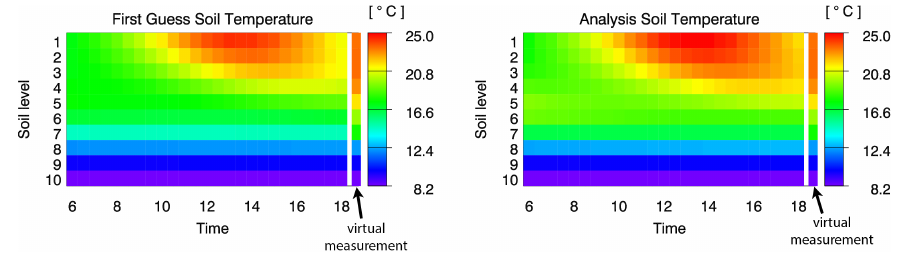
Figure 3. Time development of soil temperature profile: CLM forecast without assimilation (background run, left panel) and analysis (right panel). In each panel, the separated columns next to the 18:00 temperature profile depict the virtual measurements in soil layers 1–7.